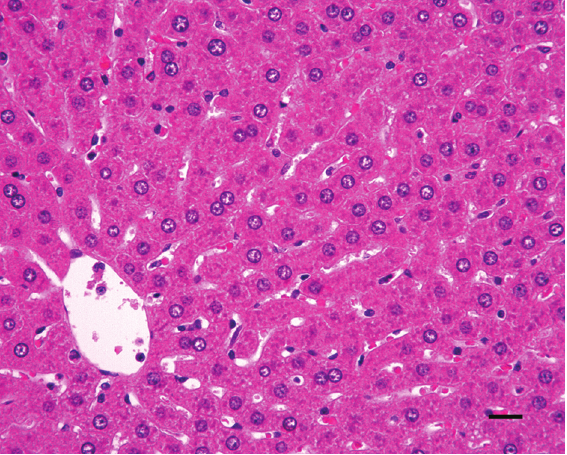
Figure 1. Liver specimen from the control group showing a nor- mal appearance. H-E, 40X (bar = 20